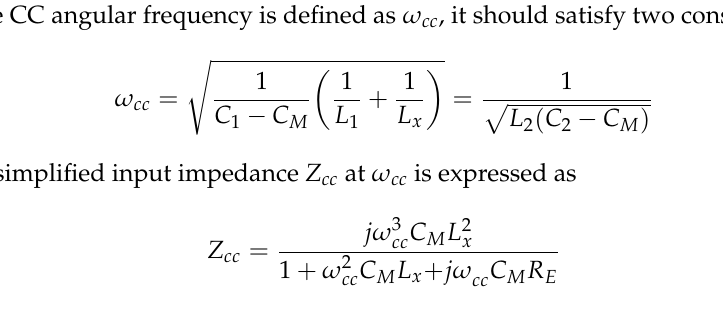
Figure 11. The simplified L x -PP CPT circuit using Π -type model to realize CC output.